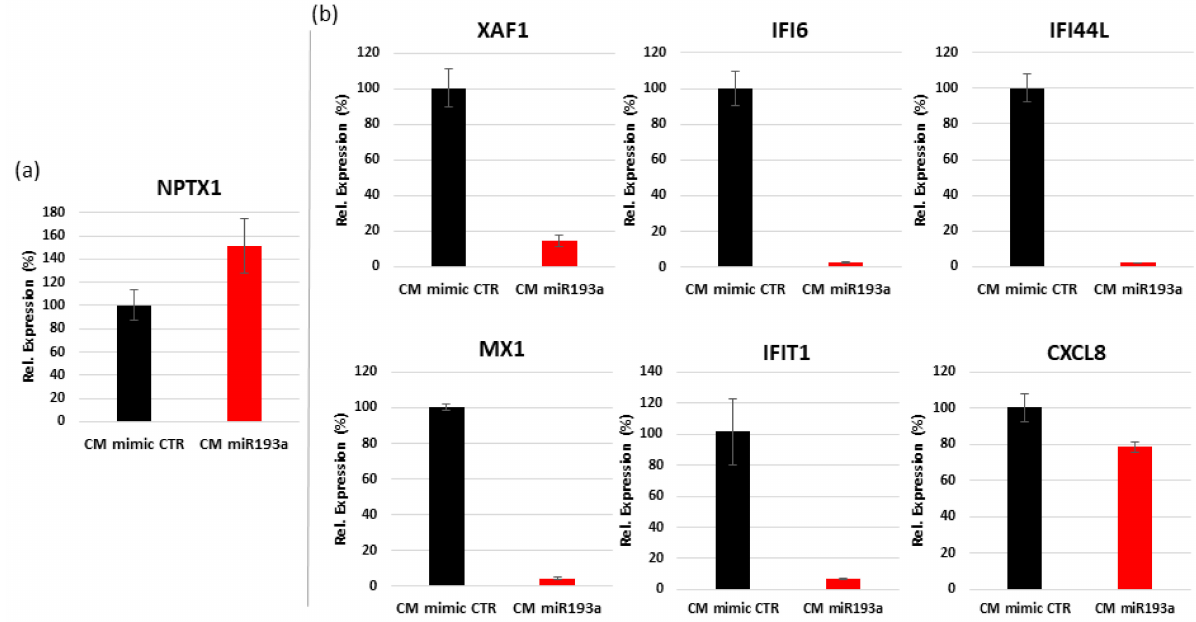
Figure 8. Validation of differentially regulated genes by RT2-PCR in VECs. Seven differentially regulated genes were randomly chosen, and validated by RT-PCR using a custom-designed RT2 PCR array from Qiagen. NPTX1 up-regulated ( a ), XAF1, IFI6, IFI44L, MX1, IFIT1 and CXCL8 downregulated ( b ). GAPDH and PDGFRB were used as internal controls and data normalization. The experiment was performed once in